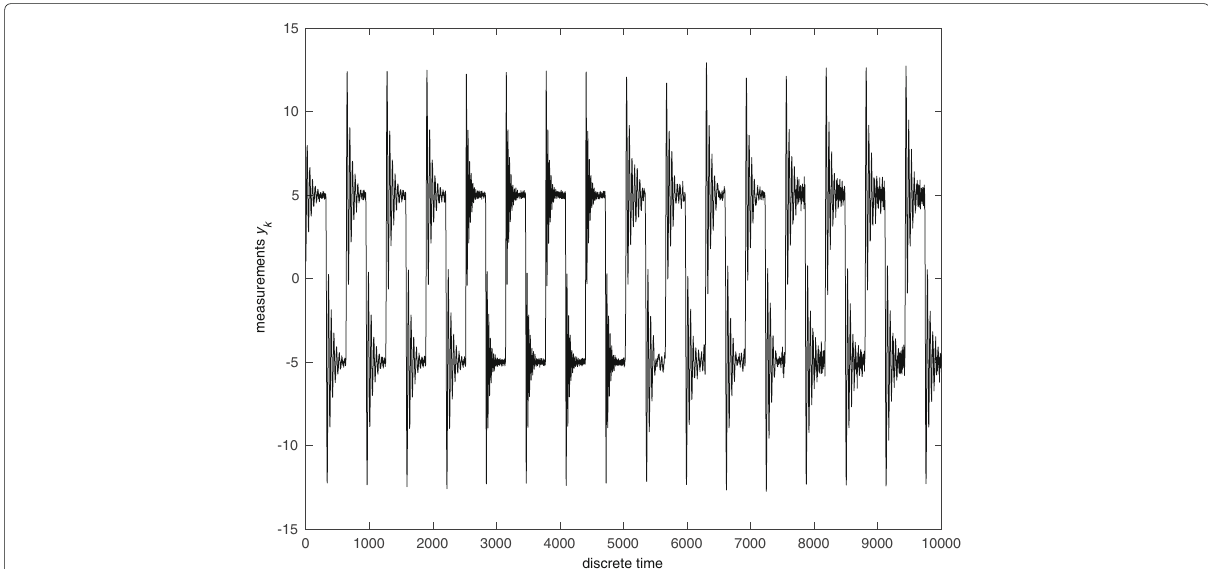
Fig. 4 Measured output signal for the oscillator (46) with operating conditions changing every 2500